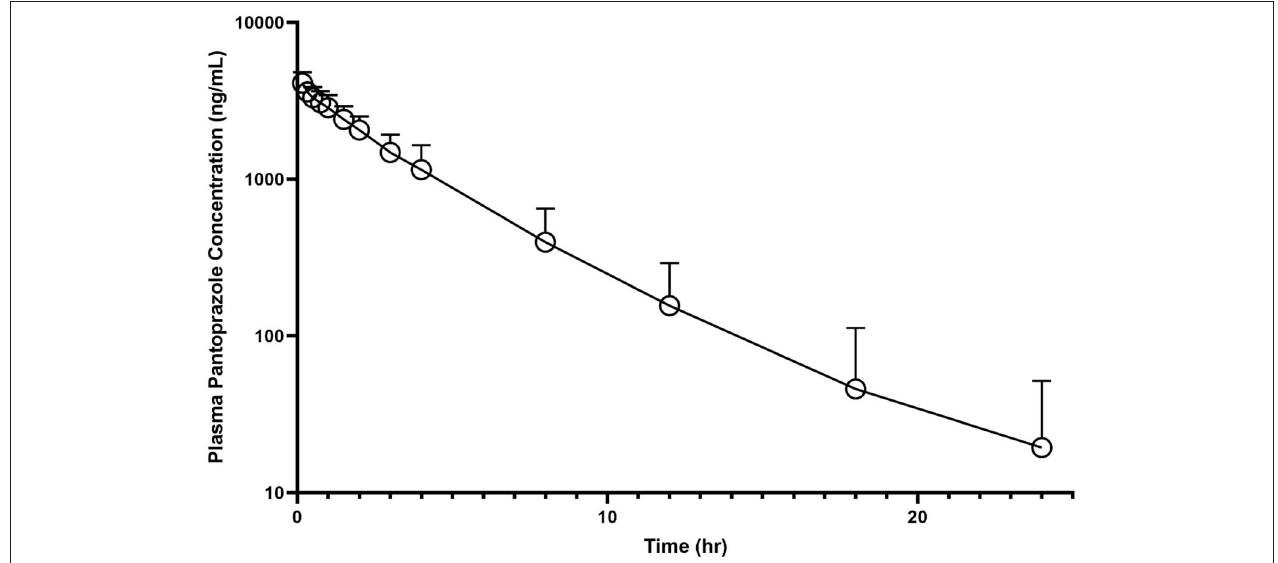
FIGURE 1 | Mean plasma pantoprazole concentration (logarithmic scale) vs. time (hr) profiles for neonatal calves ( n = 9) following intravenous (IV) single dose administration of 1.0 mg/kg of pantoprazole.